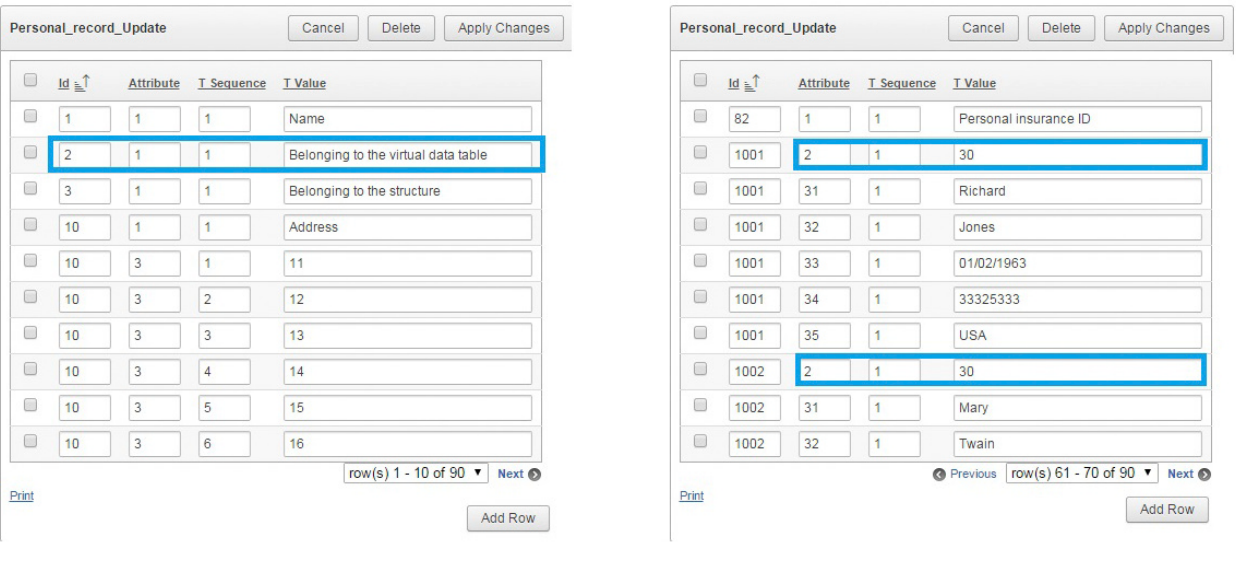
Figure 5. Belonging to the virtual data table.